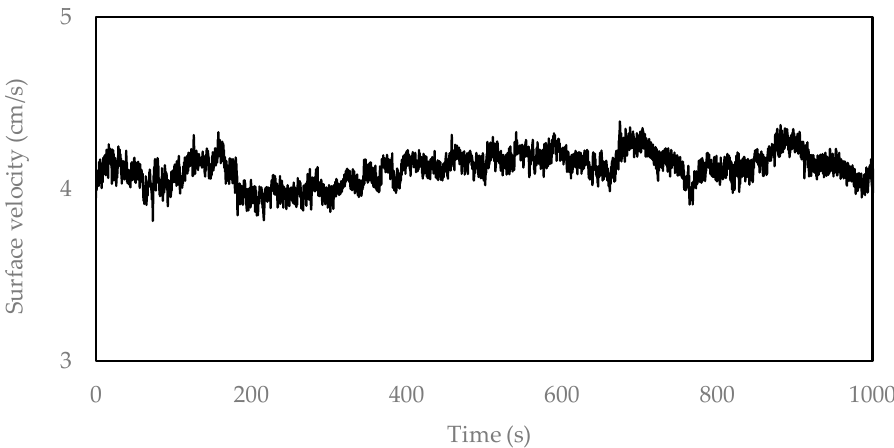
Figure 14. Temporal evolution of the sediment velocity along the vibrating channel for the sample experiment presented.